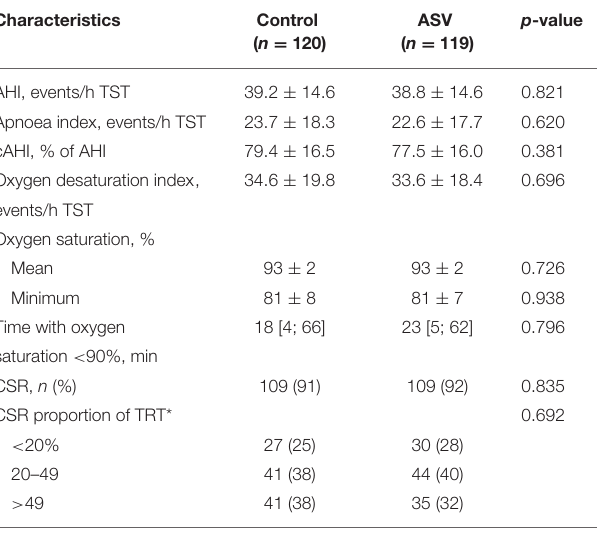
TABLE 1 | Patient demographic and clinical characteristics at baseline. TABLE 2 | Respiratory characteristics at